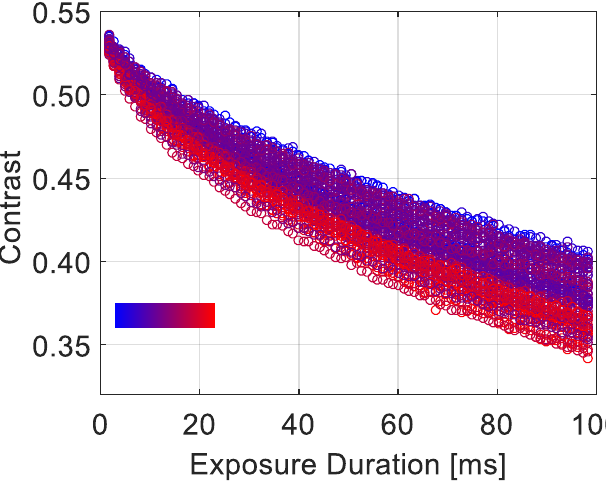
Figure 2. The contrast C , computed over rings with a 9.2 inner and 9.4 mm outer diameter, as a function of the exposure duration T exp for all 55 samples. Different colors correspond to different apples. The chosen color range is scaled as a function of the ratio of the firmness to the soluble solids content (SSC) level: blue and red correspond to lower and higher levels, respectively.